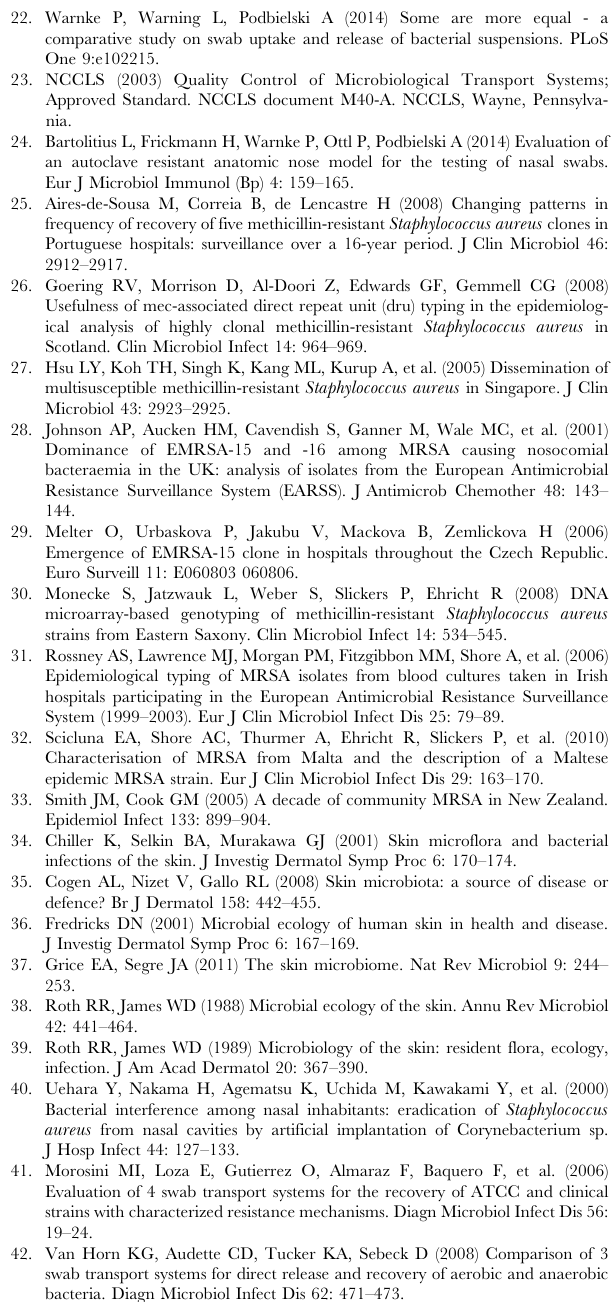
Table S1 Statistics on quantitative recovery of bacteria. All p values result from nonparametric, two-tailed Wilcoxon- Mann-Whitney U-test. CFU= colony forming units. Table S2 Statistics on relative recovery of bacteria. All p values result from nonparametric, two-tailed Wilcoxon-Mann- Whitney U-test. Table S3 Raw data. Results of CFU counting for each experiment are displayed.